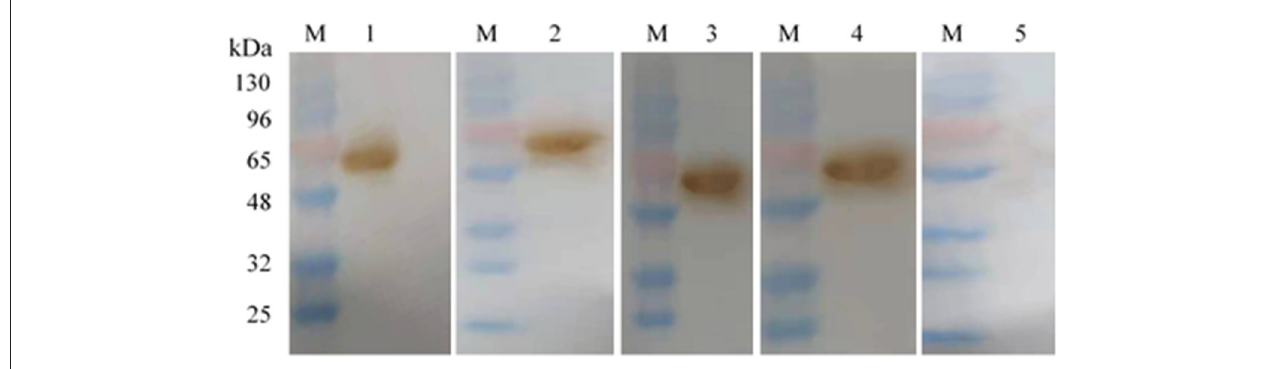
FIGURE 4 | Monoclonal antibody against Omp2 of L. intracellularis was identified by Western blot. Lane M: the prestained protein molecular weight standard; lanes 1–3: 4D9 MAb, 3G2 MAb, and 7G5 MAb, respectively; lane 4: the mouse serum against Omp2 protein; lane 5: unimmunized normal mouse